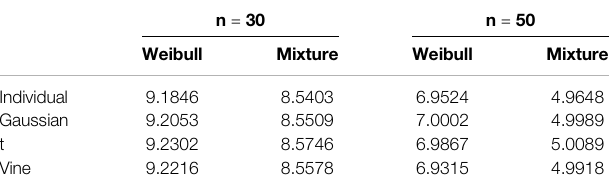
TABLE 8 | The average Mean Squared Error of aggregate losses for states in Group